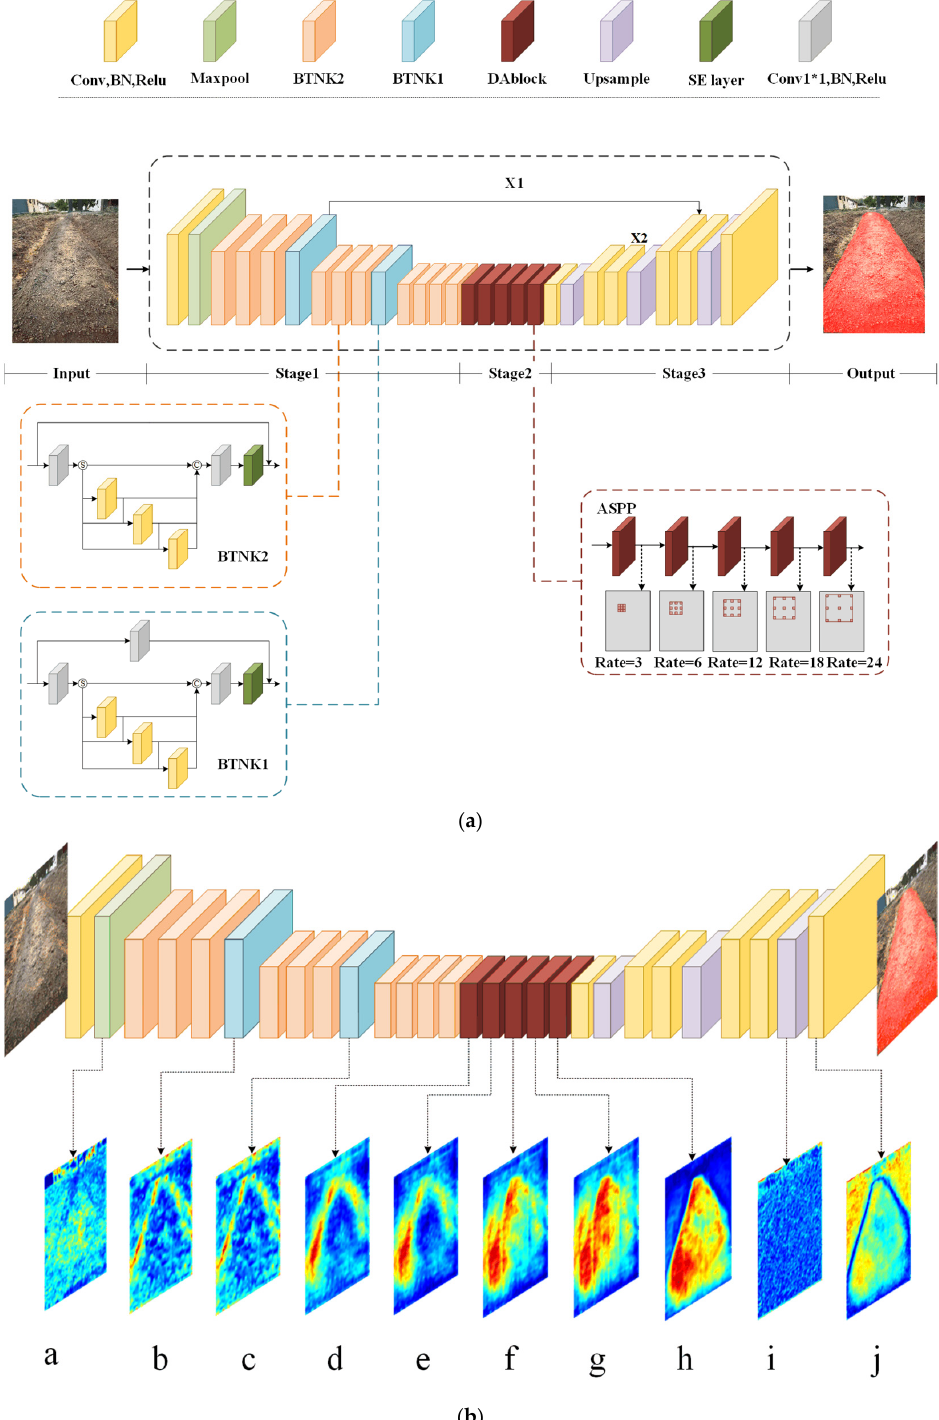
Figure 4. Model framework. ( a ) Res2net50 model after optimization. ( b ) Feature